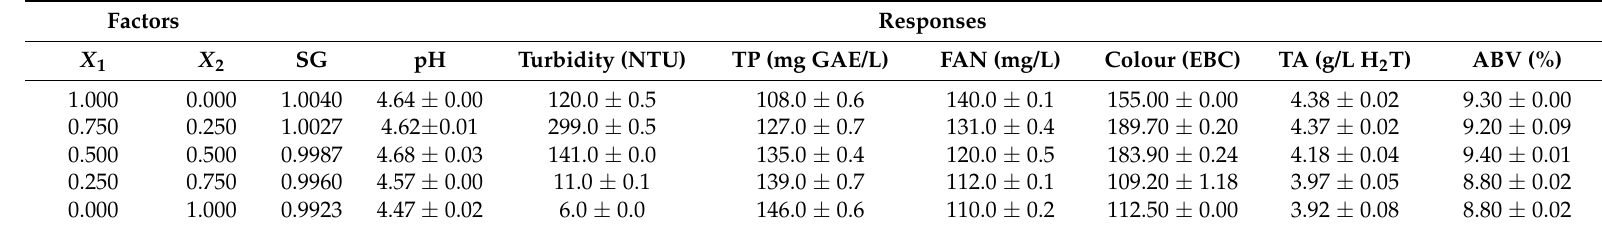
Table 6. Physicochemical characteristics of